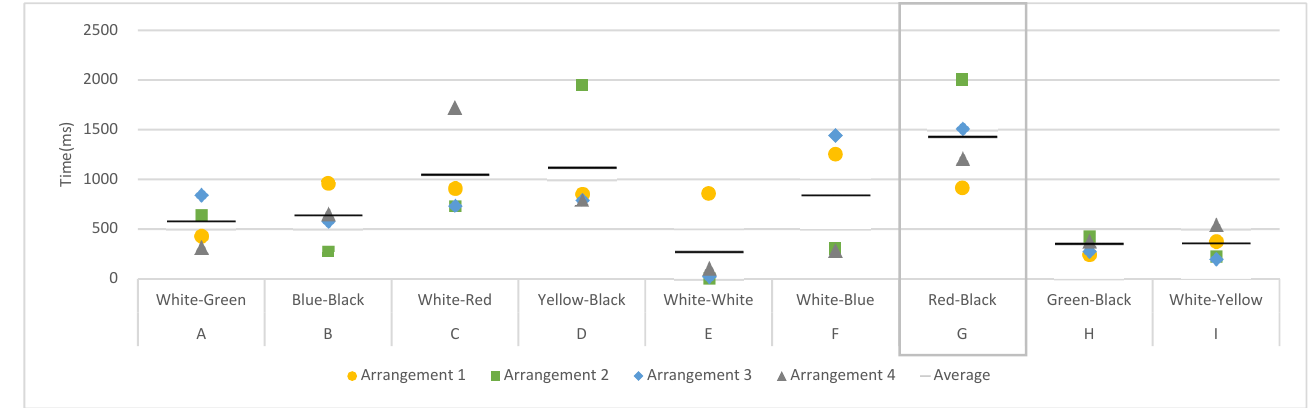
were used, the dwell times of AOI-H (black–green) and AOI-I (white–yellow) were rela- tively short, which means these colors were less attractive to the participants.